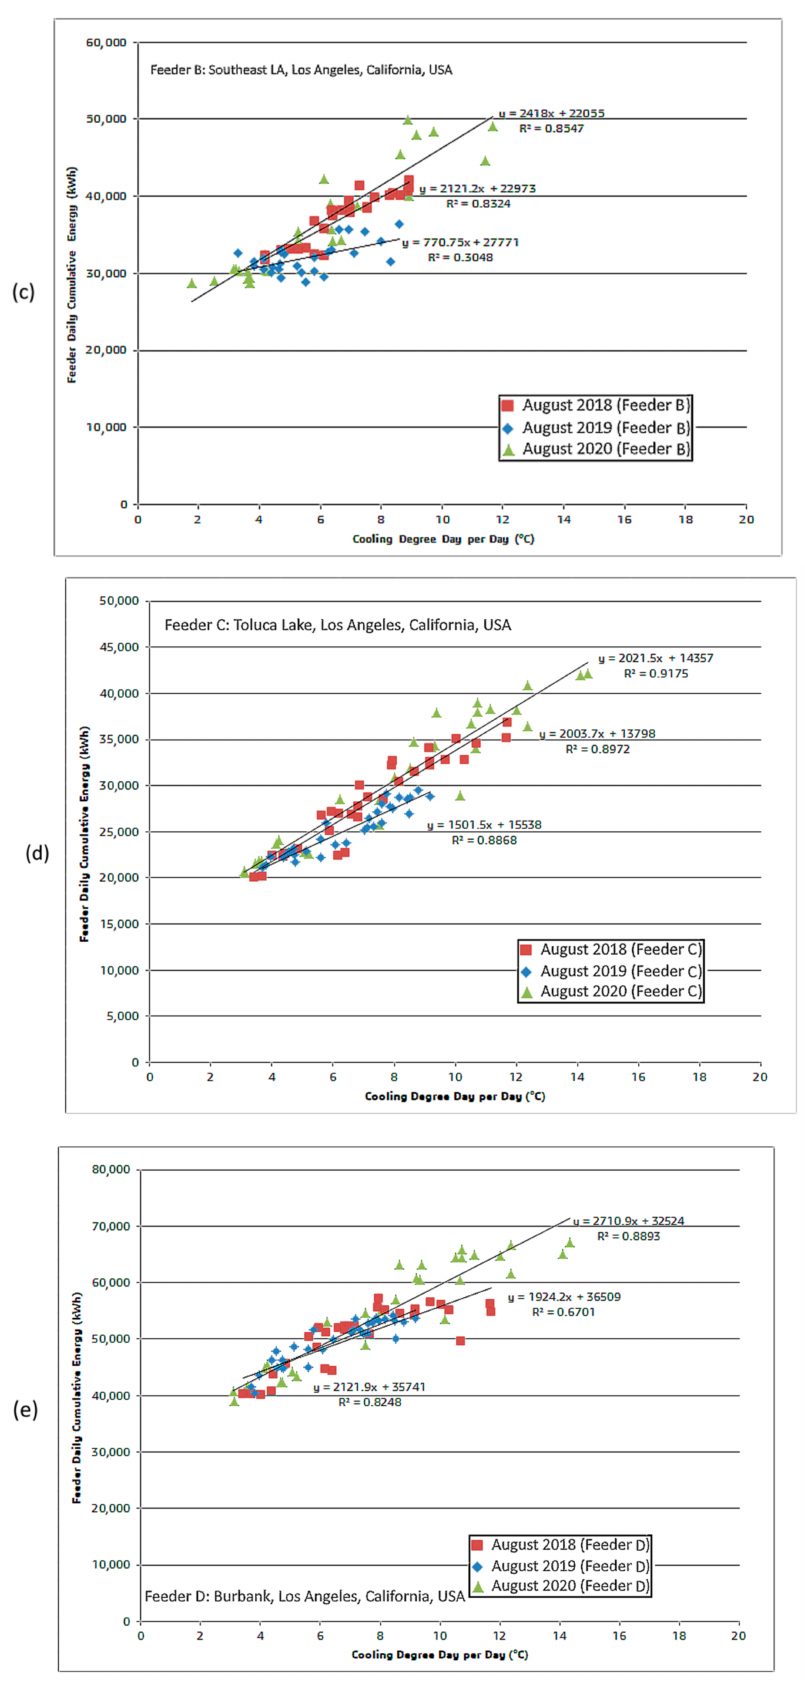
Figure 8. Comparison of feeder daily energy use for 2018, 2019, and 2020 for observed CDDs for ( a ) the month of July for Feeder A; and ( b – e ) presenting the month of August for Feeders